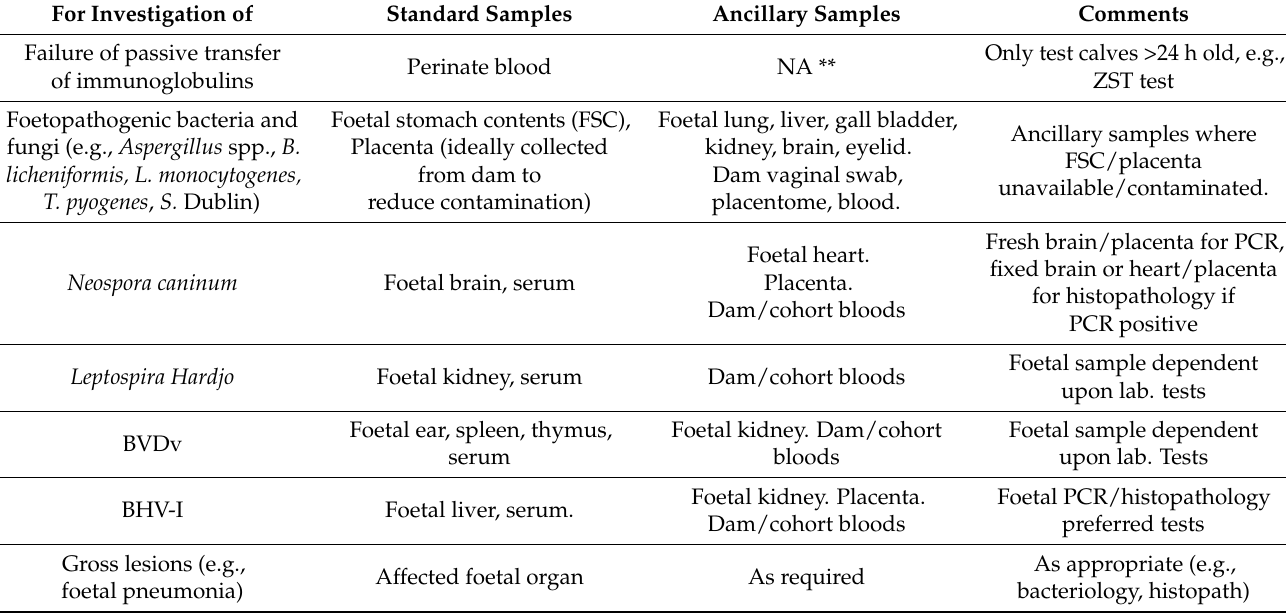
Table 4. Standard and additional samples to collect from cases of perinatal mortality * for the investigation of infectious causes of